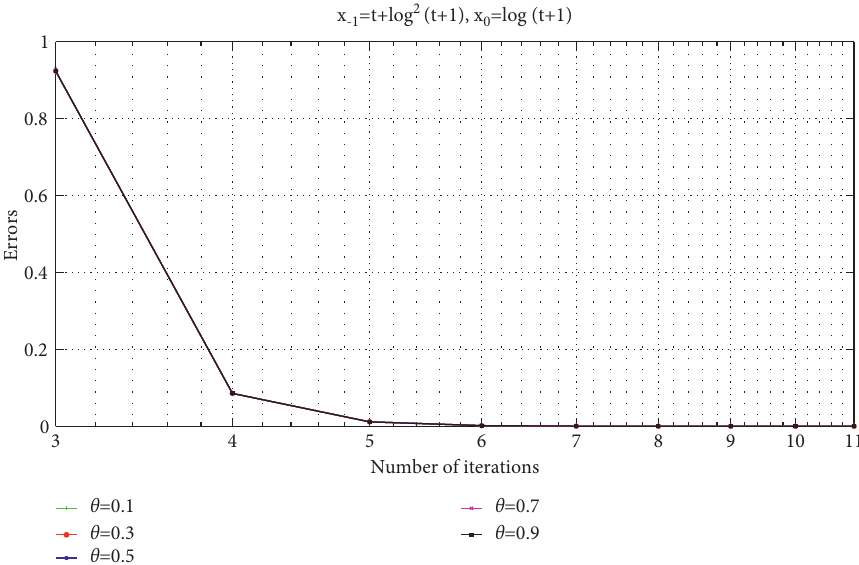
Figure 6: The Cauchy error plotting number of iterations for different parameters θ